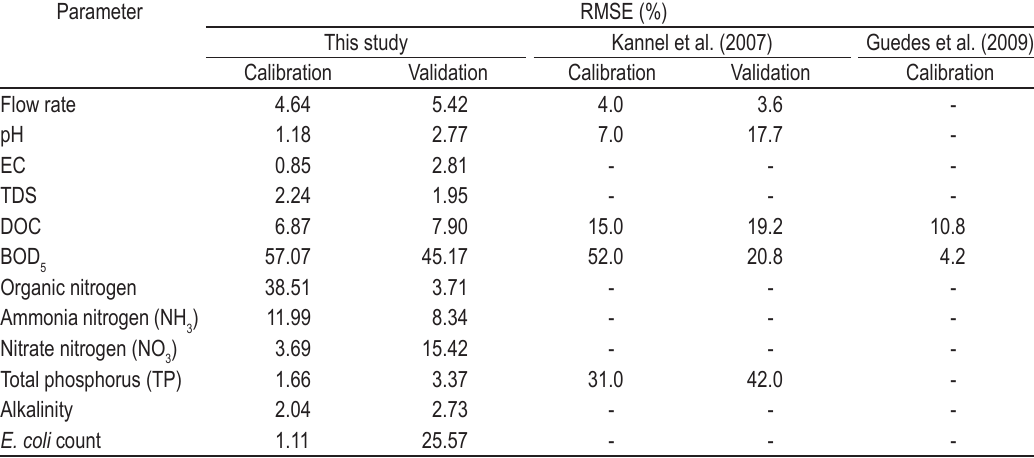
Table 6. Root-mean-square errors (RMSE) for the measured values and model predictions during the calibration period (rainy season) and the confirmation period (dry season).